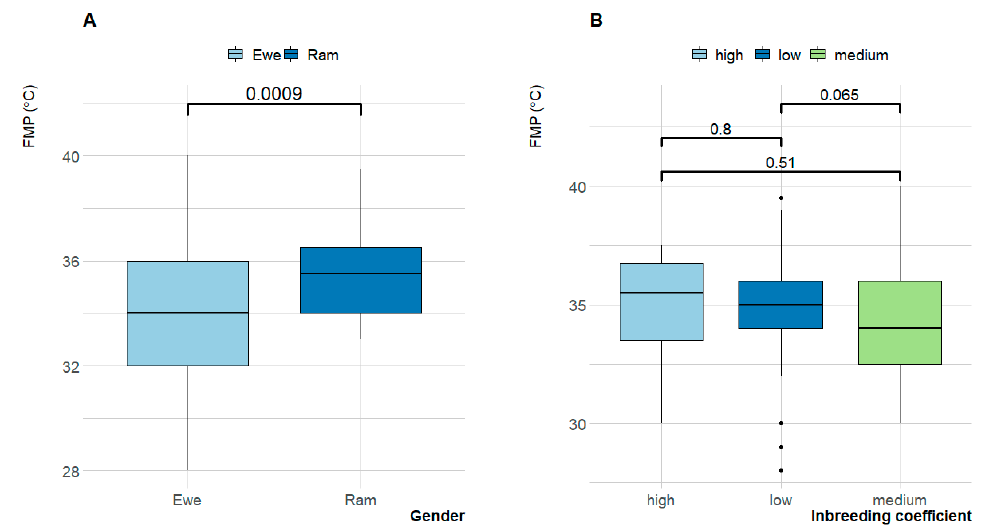
Figure 5. Variation in fat melting point (FMP) percentage of Tattykeel Australian White (TAW): ( A ) gender; ( B ) Inbreeding Coefficient (IC).